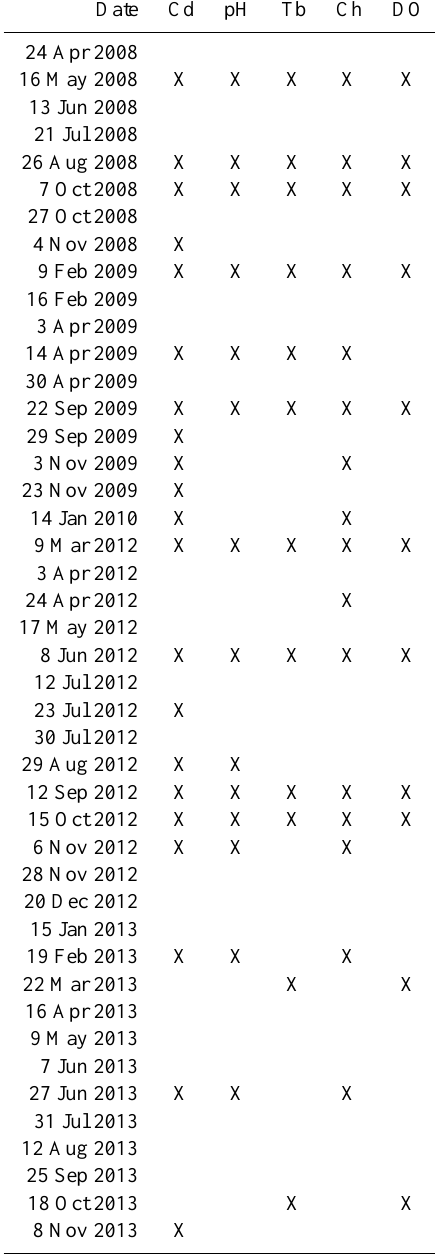
Table 2. Dates of probe maintenance operations. The crosses in- dicate sensor calibration (with Cd: Conductivity; Tb: Turbidity; Ch: Chlorophyll; and, DO: Dissolved Oxygen). No cross indicates cleaning,